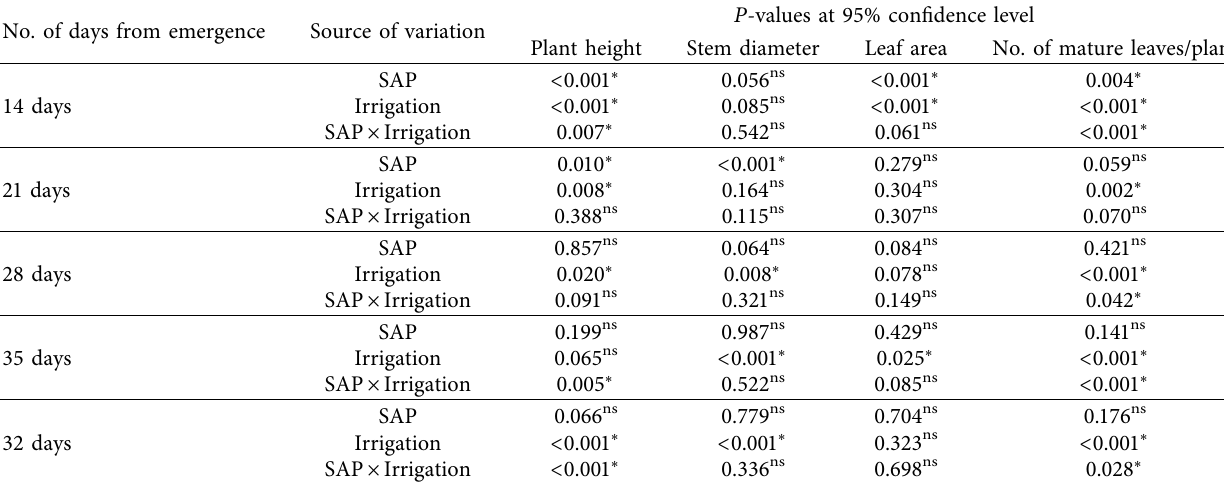
Table 4: Variation of ANOVA over 32 days of cowpea plant from